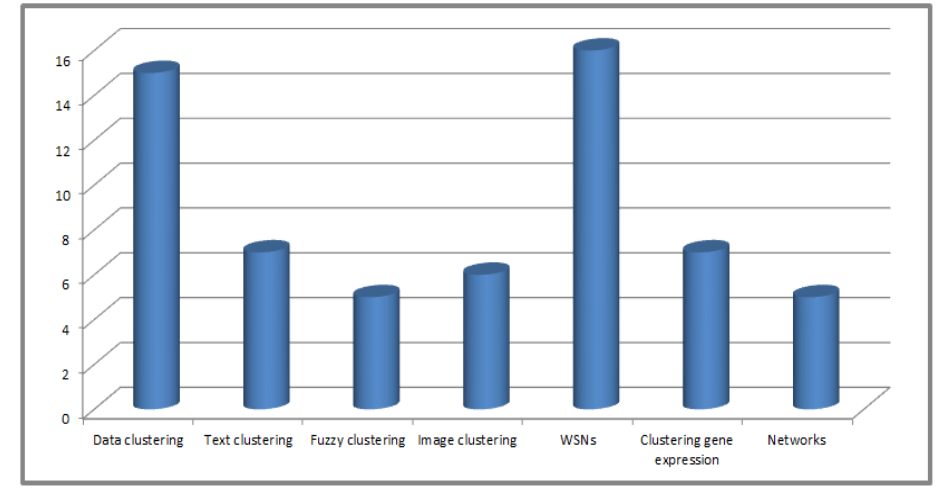
Figure 3. Number of publications on clustering applications of the HSA since it was proposed until the first half of 2020. WSN = Wireless Sensor